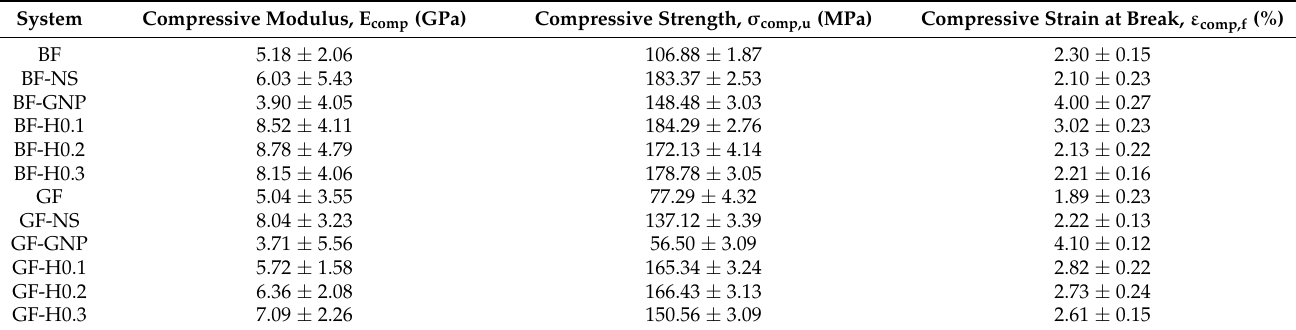
Figure 5. Typical compressive stress-strain response of GFRP and BFRP embedded with hybrid nanofiller. Table 5. Compressive properties of FRP embedded with hybrid